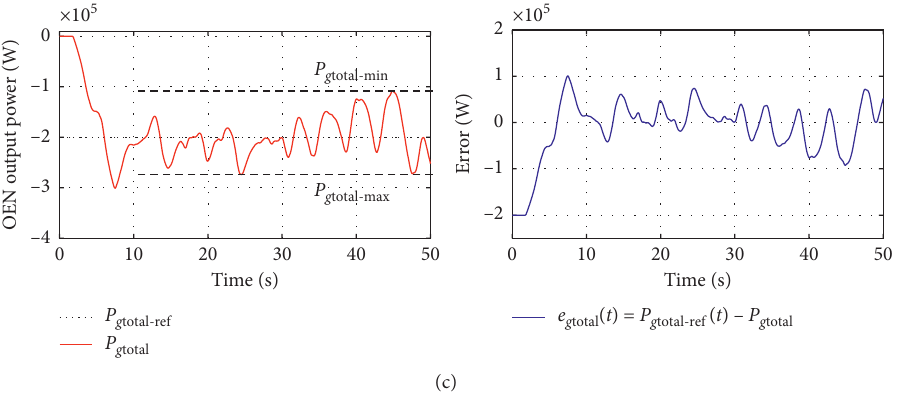
� − 50kW, g total − ref